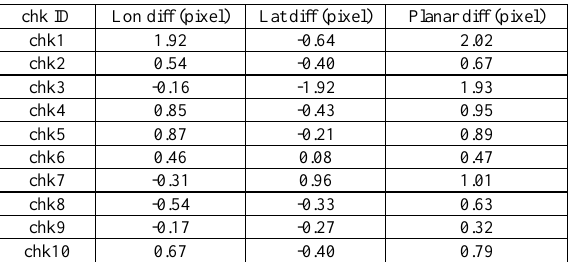
Table 2. Check point precision of TPS-based DOM registration between Part1 and Part2 subarea DOMs